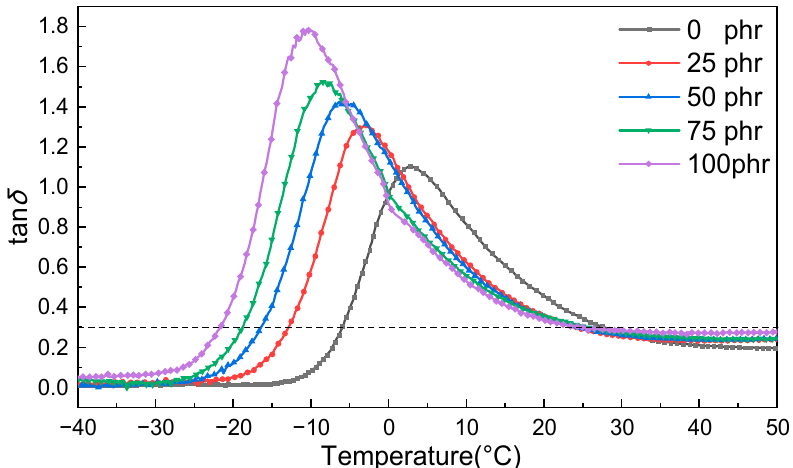
Figure 2. Effect of CP52 content on the damping performance of NBR.